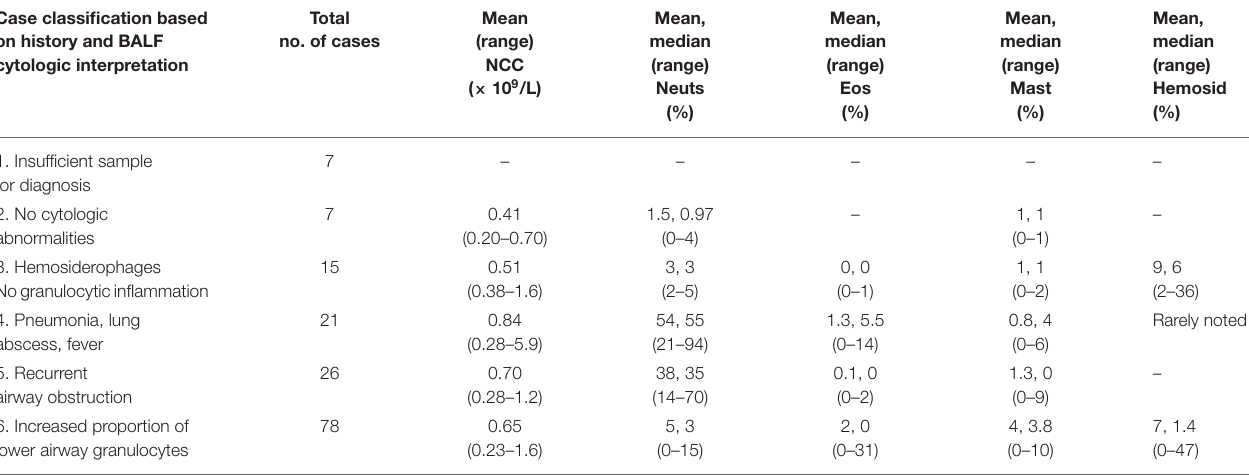
TABLE 1 | Classification of case data from 154 horses living within a 30-km radius of either Guelph or Kitchener, Ontario (2007–2017). Case classification based on history and BALF